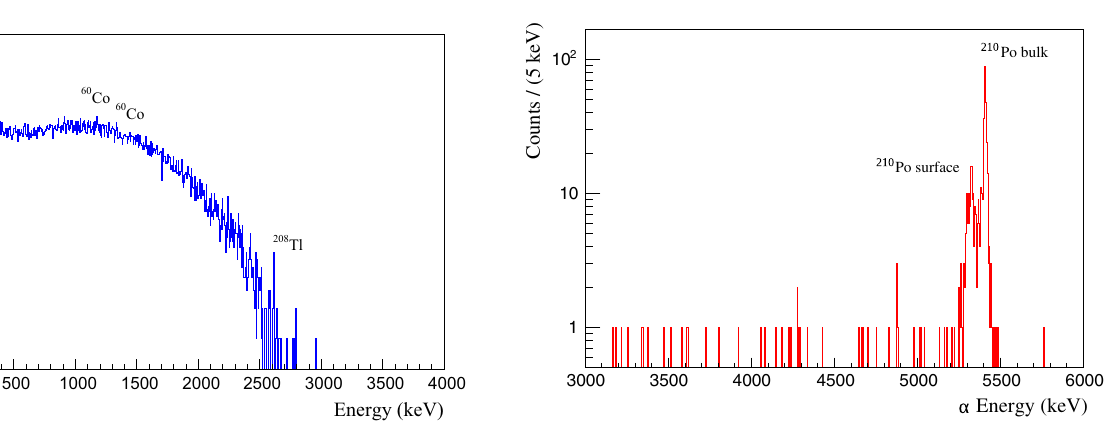
keV we observe 14 events, which is equivalent to a